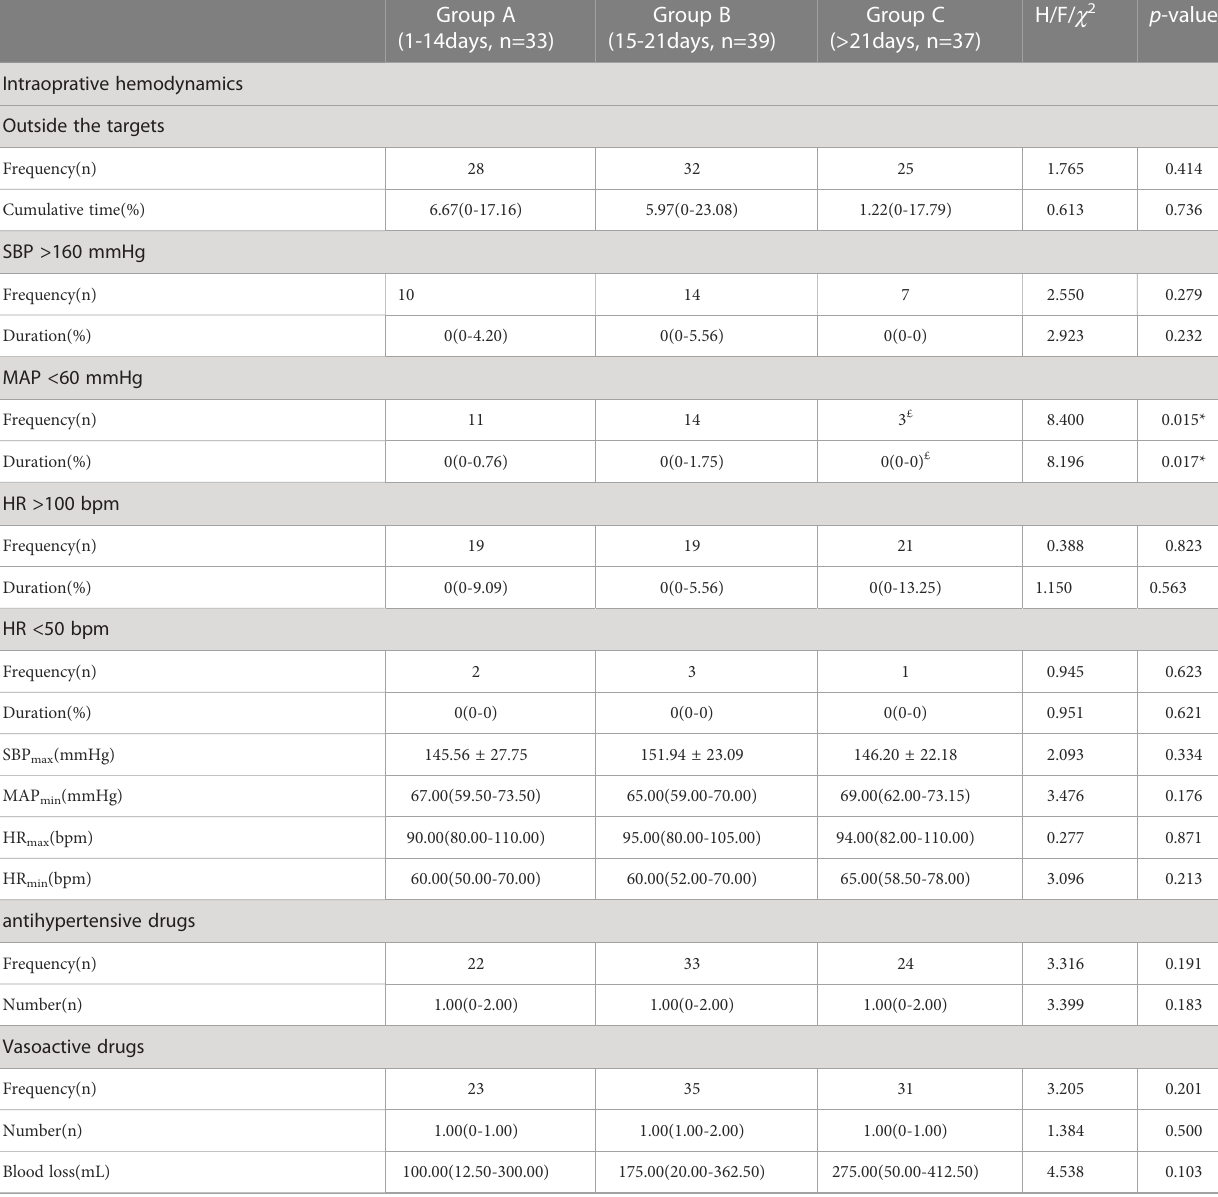
TABLE 6 Perioperative hemodynamics of three groups with PPGL according to the duration of administration of